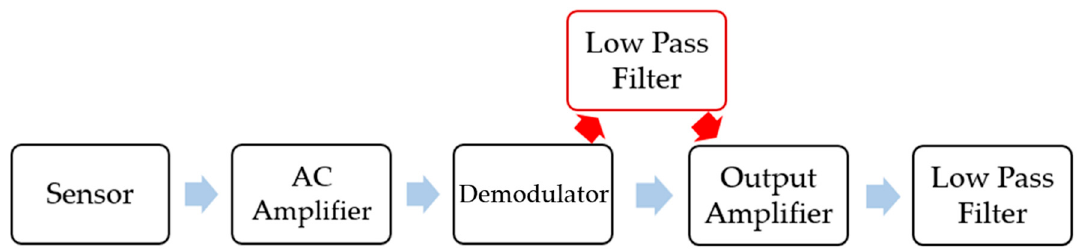
Figure 14. A preposition low-pass filter.